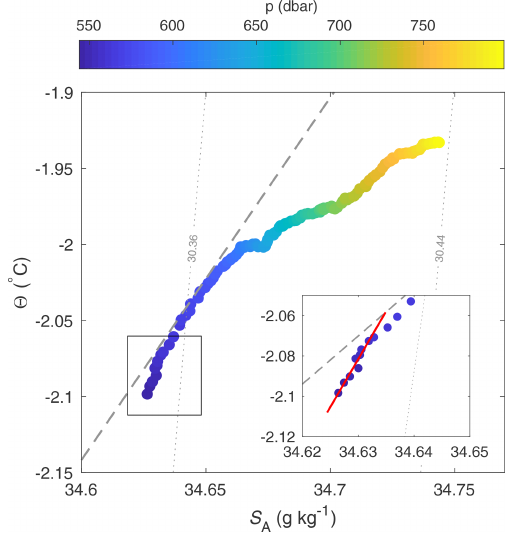
Figure 3. (cid:50) – S A plot of the four-profile mean from Fig. 2 coloured by pressure. A meltwater mixing line with gradient d (cid:50)/ d S A = 2.38 ◦ Ckgg − 1 calculated following McDougall et al. (2014) is shown (dashed grey line) alongside the local isopycnal slopes (dotted grey lines). The inset shows a line of best fit for the upper 15m of the water column (red line), which has gradient d (cid:50)/ d S A = 4.8 ◦ Ckgg − 1 .